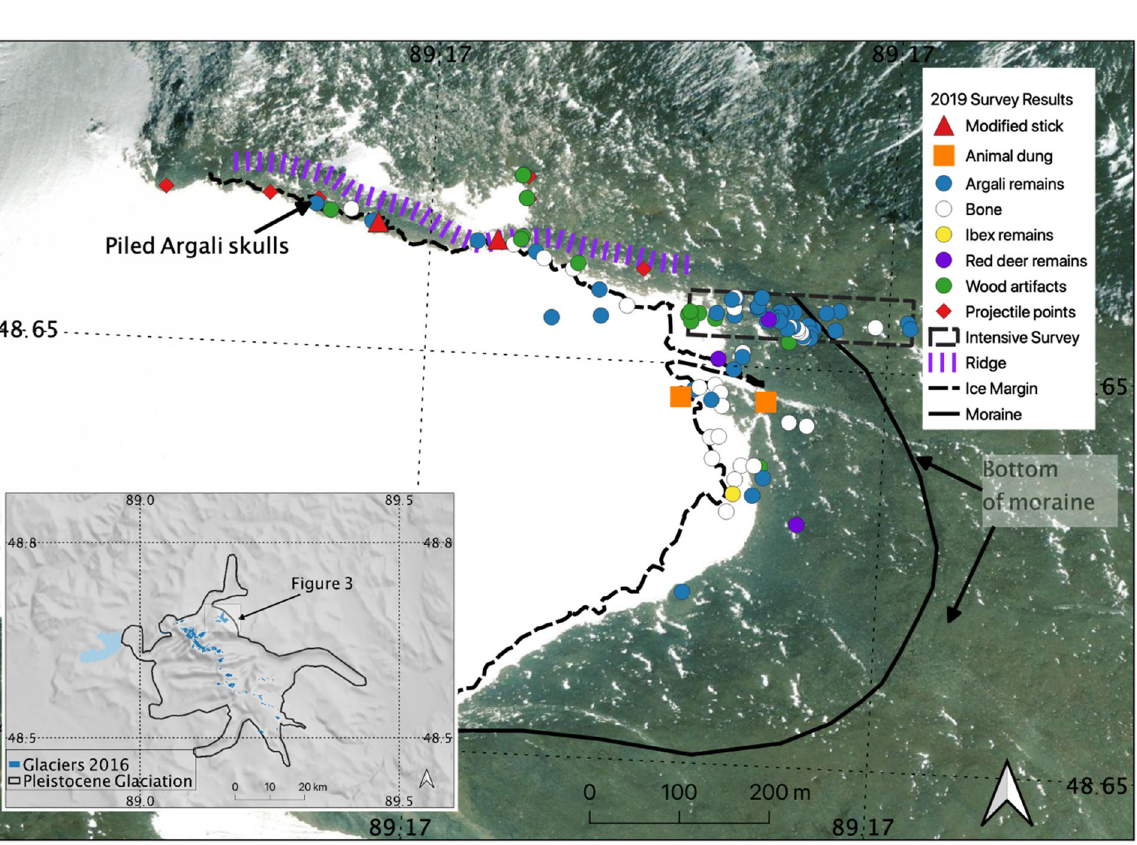
Figure 3. Results from pedestrian survey at Tsengel Khairkhan glacier. Imagery from ArcGIS High Resolution World Imagery dataset. Moraine represents maximum extent of Little Ice Age glaciation. Produced in QGIS 3.10 (http:// www. qgis.